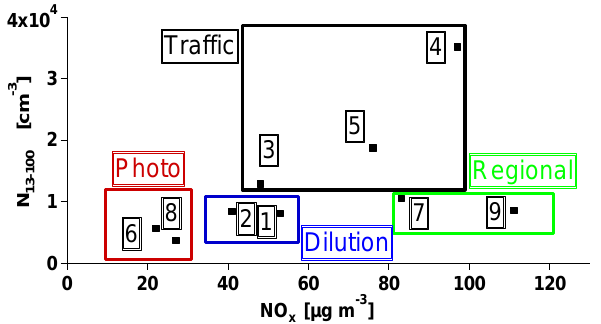
Fig. 6. Particle number concentrations N 13 − 100 nm versus NO x . Points are average values for the nine solutions indentified by k- means clustering analysis, merged as discussed in Sect. 4.1 as Dilu- Figure 6 . Particle number concentrations N 13-100nm versus NO x . Points are average values for7 tion, Traffic, Photo-nucleation and regional the nine solutions indentified by k-means clustering analysis, merged as discussed in section8 4.1 as Dilution, Traffic, Photo-nucleation and regional scenarios9